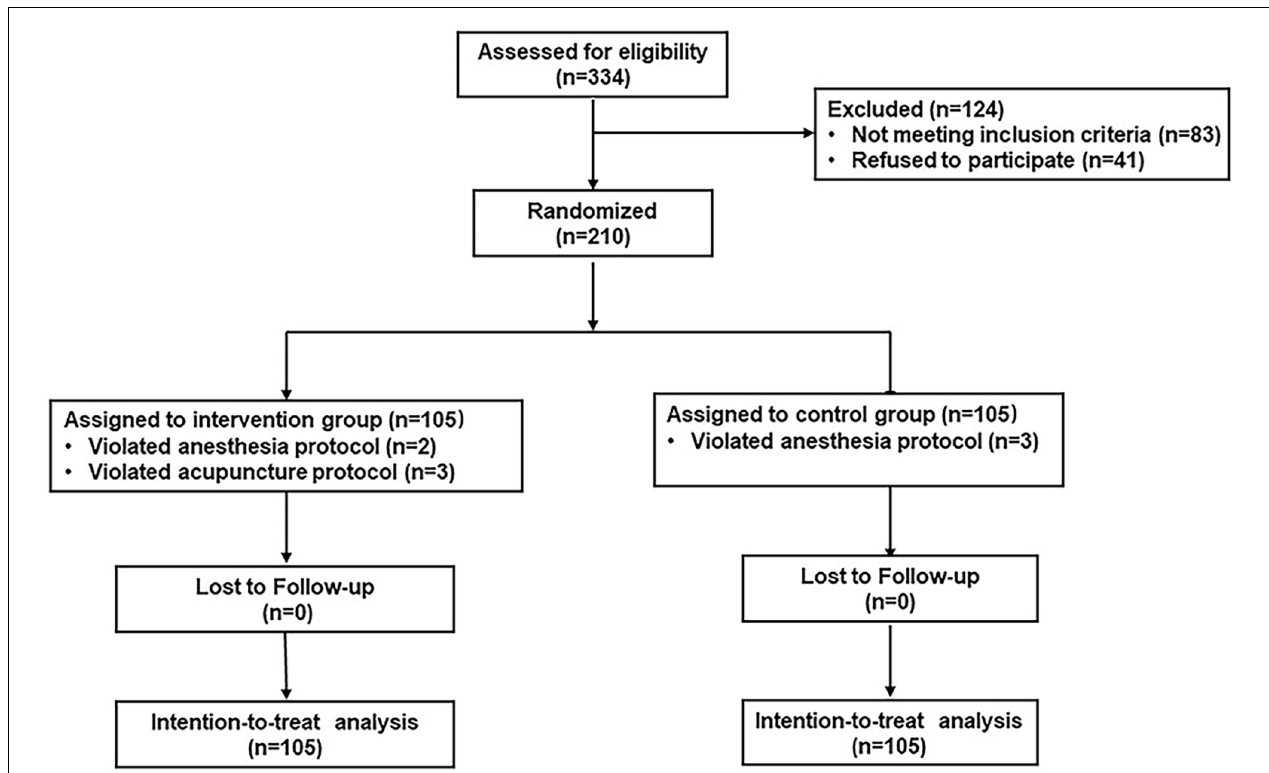
FIGURE 1 | Trial profile. The intention-to-treat analysis included all randomized patients in the groups in which they were randomly assigned.